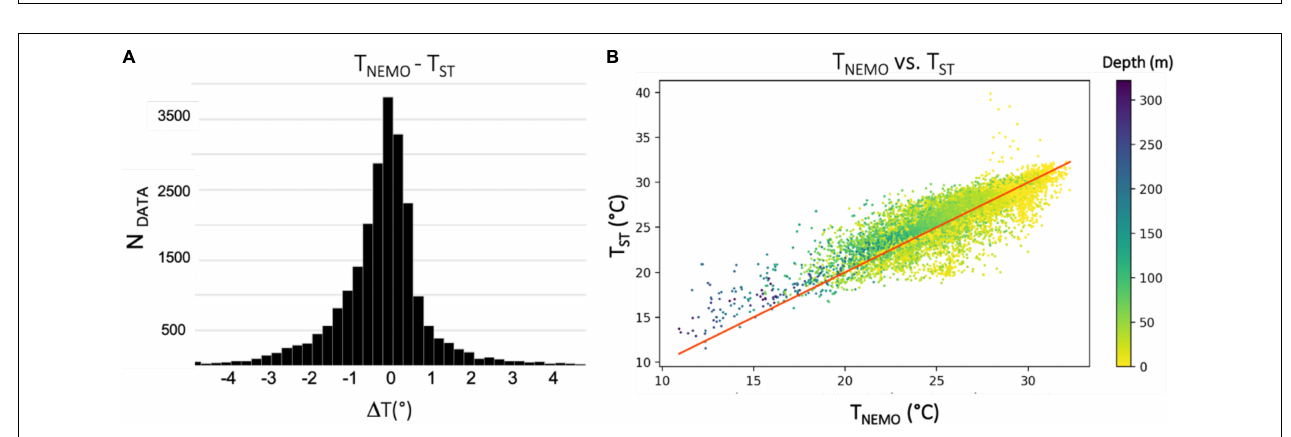
FIGURE 8 | As in Figure 7 , but for (A) Histogram and (B) scatterplot of differences between SST collected by STs (SST ST ) and forecasted with Glo12 (SST NEMO ).